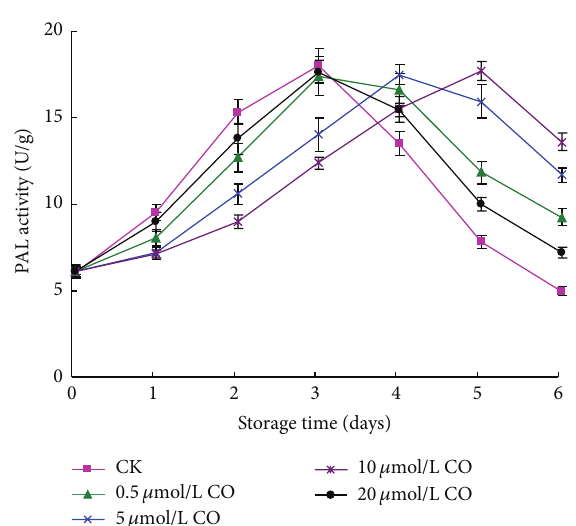
Figure 4: Effect of CO fumigation on PAL activity of postharvest peaches. Each point represents the mean value ±